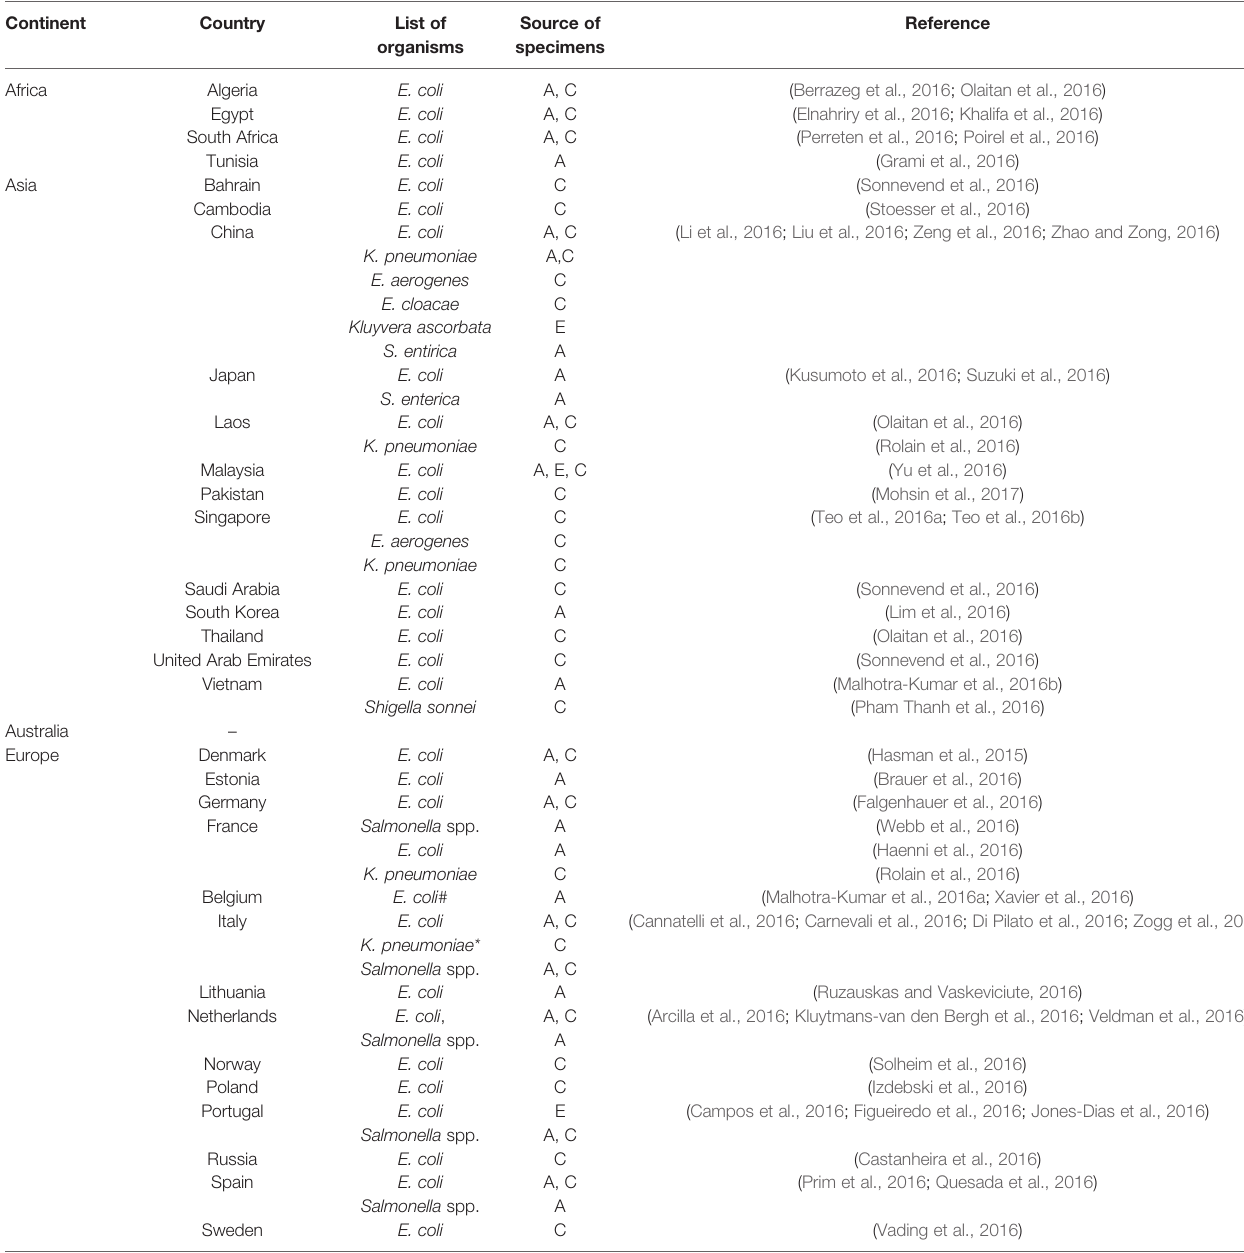
TABLE 1 | List of countries that reported the mcr-1 gene in